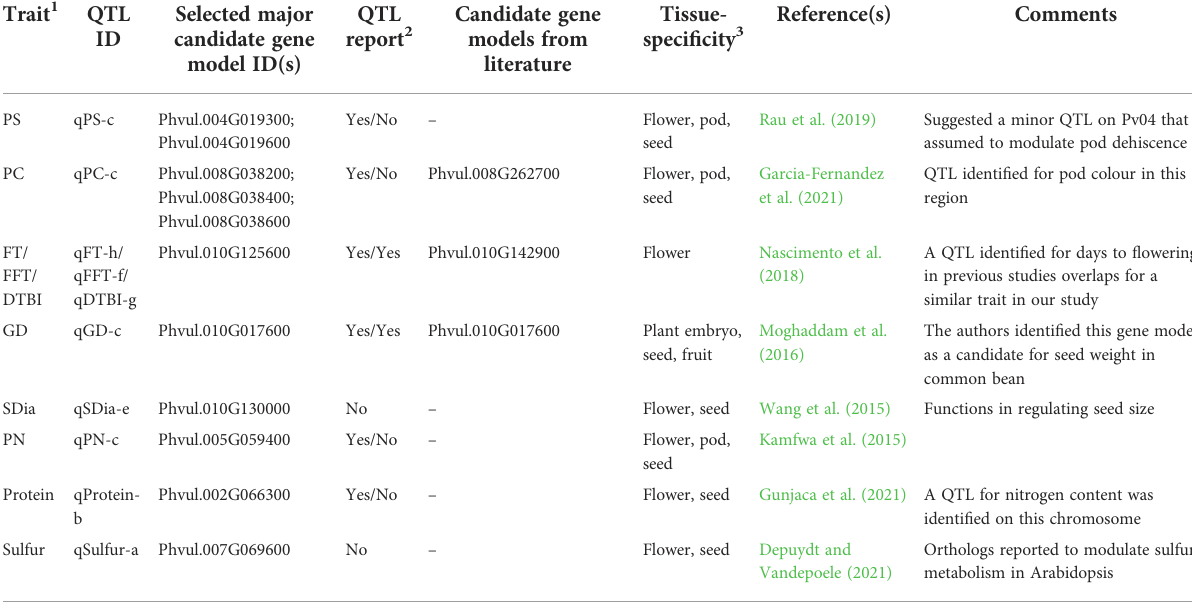
1 Refer to Table 1 for trait abbreviations, 2 QTL reported previously on the same chromosome, but exact position unknown/QTL reported previously on the same chromosome and co- localizing, 3 Information for the tissues where genes are expressed in were obtained for gene orthologs in A. thaliana